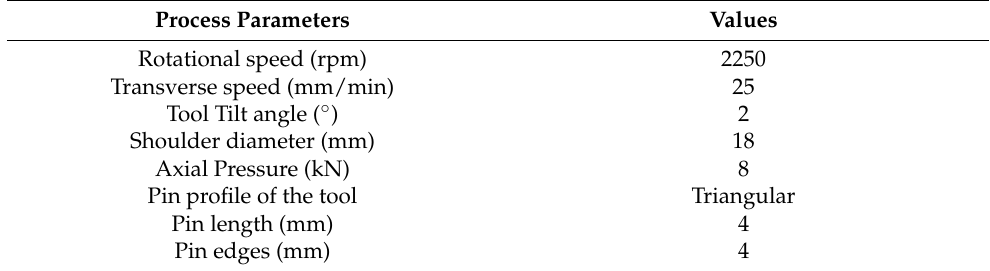
Table 1. Process parameters used in the fabrication of Al359/Si 3 N 4 /Eggshell surface composites.